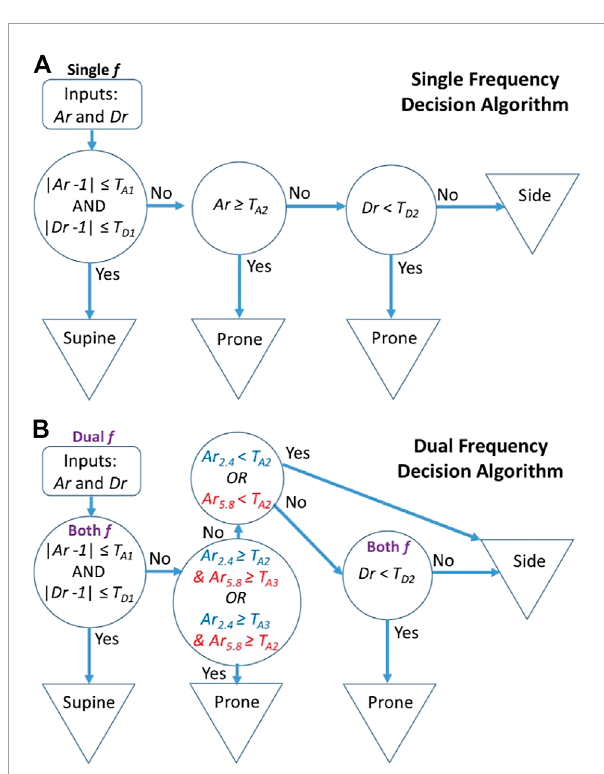
FIGURE 6 Flow charts for expert model decision algorithms for determining sleep posture from dual-frequency radar measurements. Subject sleep posture is determined based on arc radius ratio (Ar) and displacement magnitude ratio (Dr) threshold tests. The single frequency decision is based on two threshold assessments for both Ar and Dr (A) , while the dual frequency decision introduces a third threshold test for both Ar and Dr (B) (Kiriazi et al.,